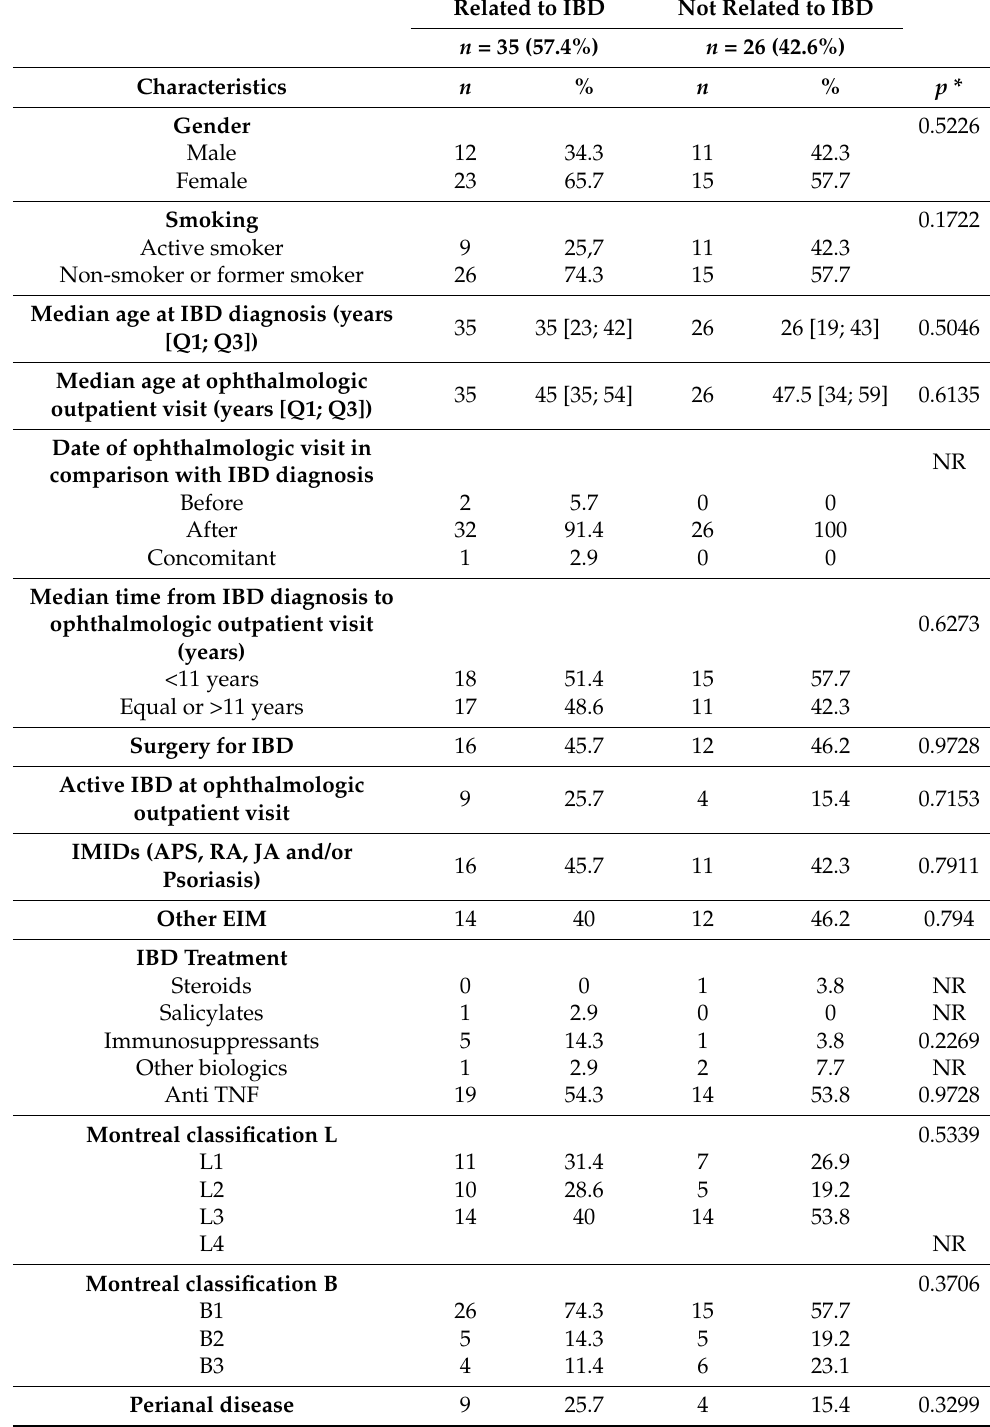
Table 4. Risk factors for ocular manifestations in patients with Crohn’s